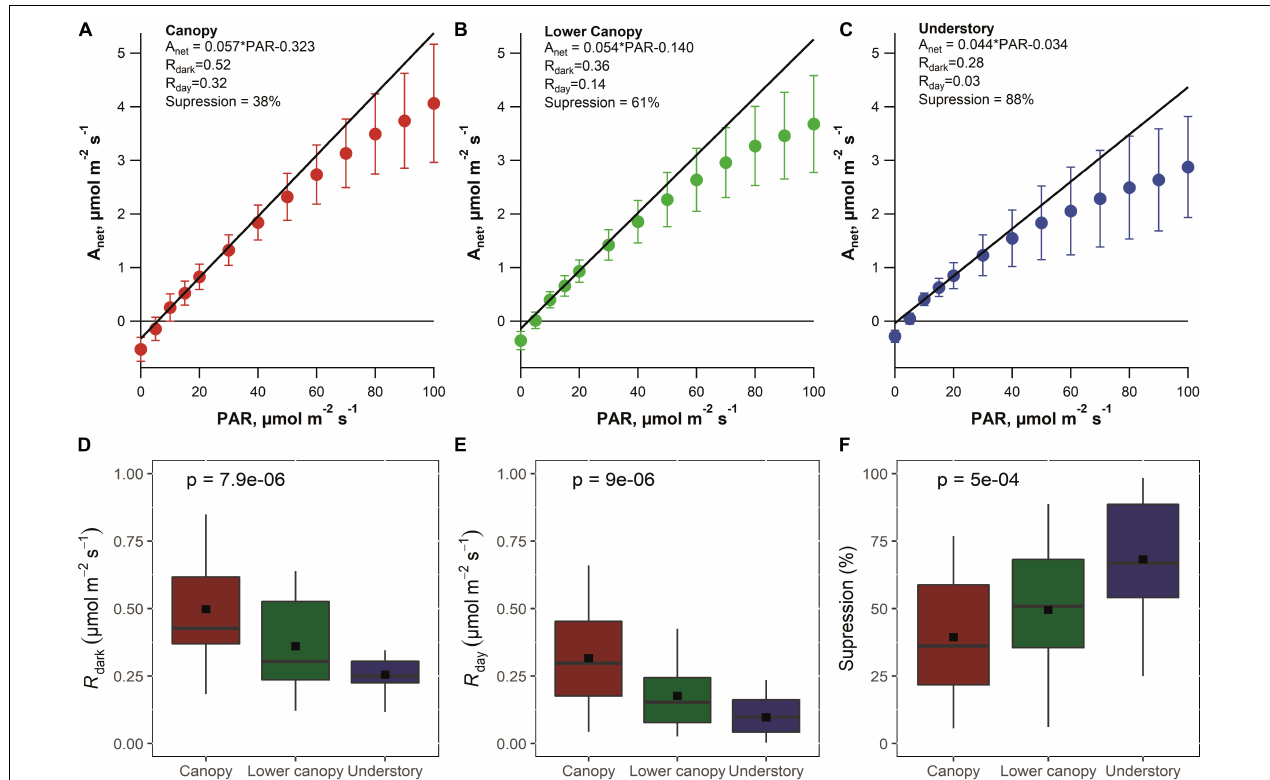
FIGURE 3 | Light response curve showing the Kok effect for each class of crown position: (A) canopy, (B) lower canopy, and (C) understory. The linear regressions for each canopy position were adjusted using values between 10 and 20 of PAR. These values are related to the abrupt change in the quantum yield (QY) of net CO 2 assimilation. The y-intercept of each adjusted linear regression was used to obtain apparent light respiration, and was estimated using the Kok method. Points are the average of leaves measured during 2019 in three different campaigns, and the vertical line represents the standard error (understory, n = 24; lower canopy, n = 27; canopy, n = 26). The second part of the figure shows the boxplots containing (D) respiration rates in the dark (R dark ), (E) apparent respiration rates in the light (R day ), and (F) apparent suppression of light respiration relative to the dark. Each colored box represents the variation of 50% of the data, the line inside each box indicates the median, the vertical lines represent the nineteenth percent of the variation, and the square point inside the colored box represents the mean (understory, n = 24; lower canopy, n = 27; canopy, n = 24–26). p values are shown for the non-parametric, Kruskal–Wallis